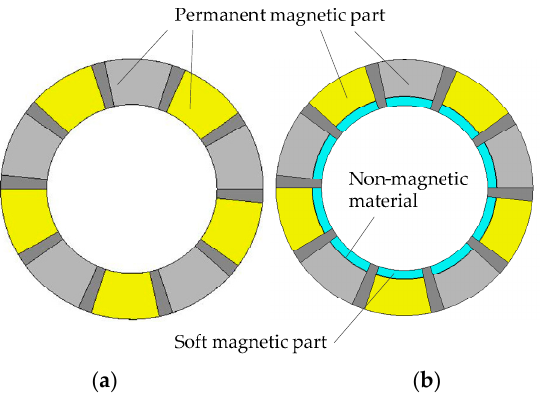
Figure 2. Optimization of rotor: ( a ) Original rotor; ( b ) Optimized rotor.